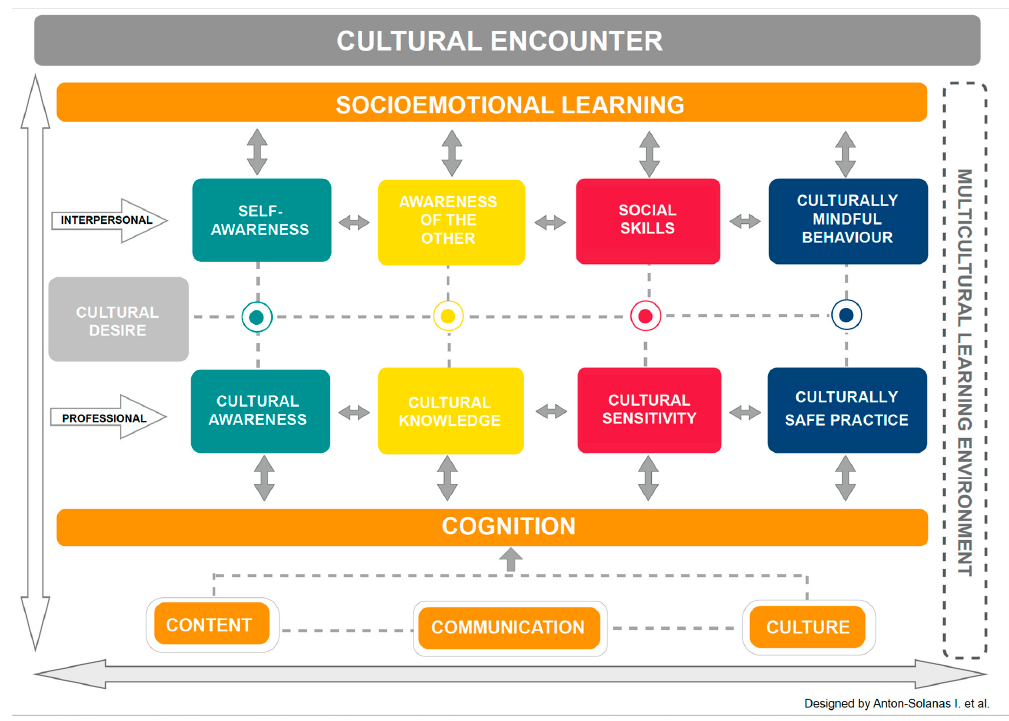
Figure 1. The Cultural Competence in a Multicultural Environment (CCMEn) Model.